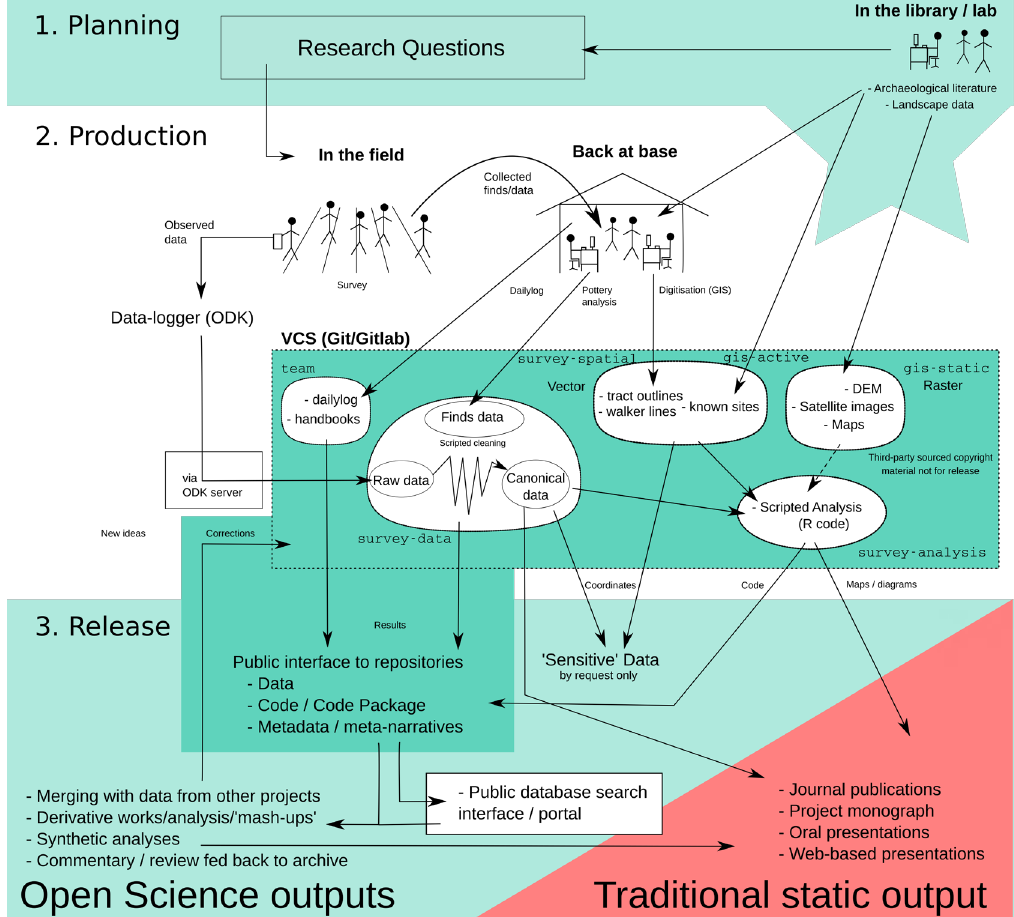
Figure 4. A simplified graphical representation of the VCS-oriented data management for Project